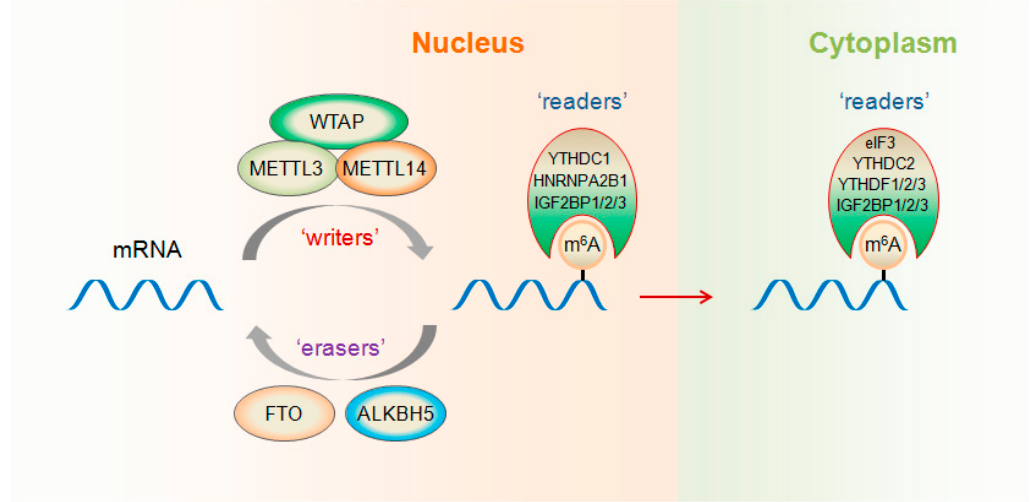
Figure 1. The writer, eraser, and direct reader proteins of N 6 -methyladenosine (m 6 A). m 6 A modification is dynamically regulated by writers (METTL3 or METTL14) and erasers (fat mass and obesity-associated (FTO) or ALKBH5), both of which are localized primarily in the nucleus. In the nucleus, m 6 A can be recognized and directly bound by m 6 A readers YTHDC1, HNRNPA2B1, andIGF2BP1/2/3. In the cytoplasm, m 6 A can be recognized and directly bound by m 6 A readers YTHDF1/2/3, YTHDC2, eIF3, and IGF2BP1/2/3. Recognition and binding of m 6 A by different readers in the nucleus or cytoplasm mediate divergent biological functions. WTAP, Wilms’ tumor 1-associating protein.